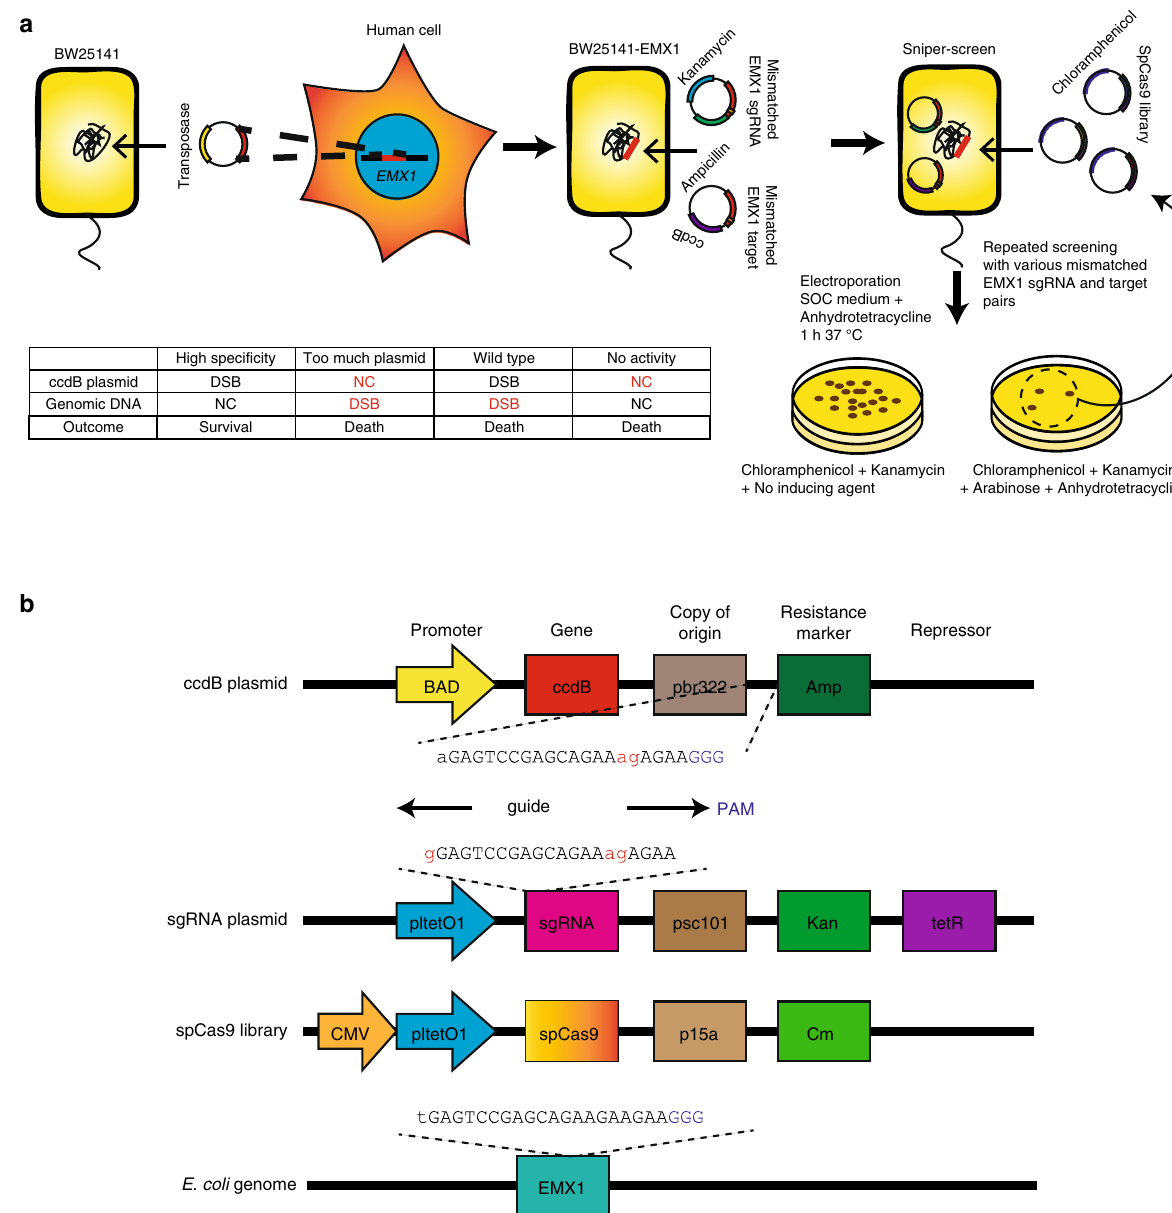
Fig. 1 One-step positive and negative selection scheme in E. coli. a Schematic of the Sniper-screen. Cell death is indicated by red type. b Plasmid design with sample sgRNA and target sequences with mismatches in the fi fth and sixth positions of the guide sequence targeting the EMX1 gene. DSB: double strand break, NC: no